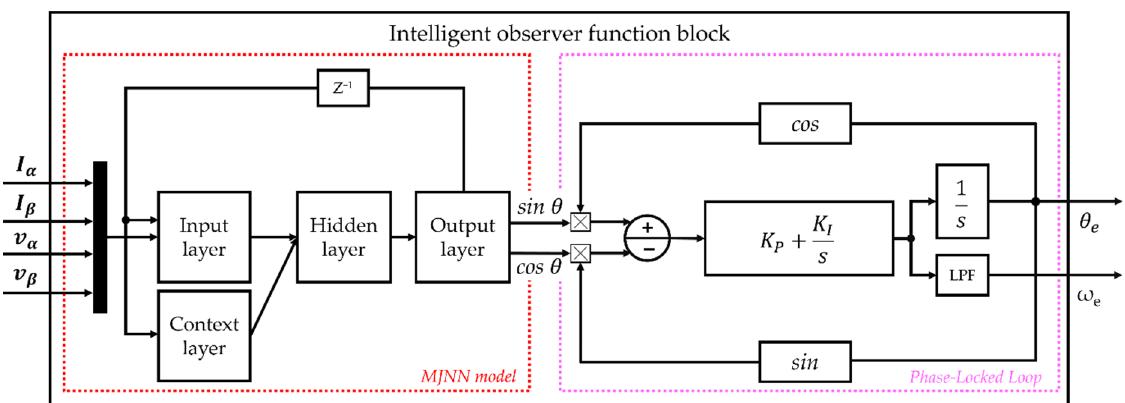
Figure 11. Intelligent observer function block.